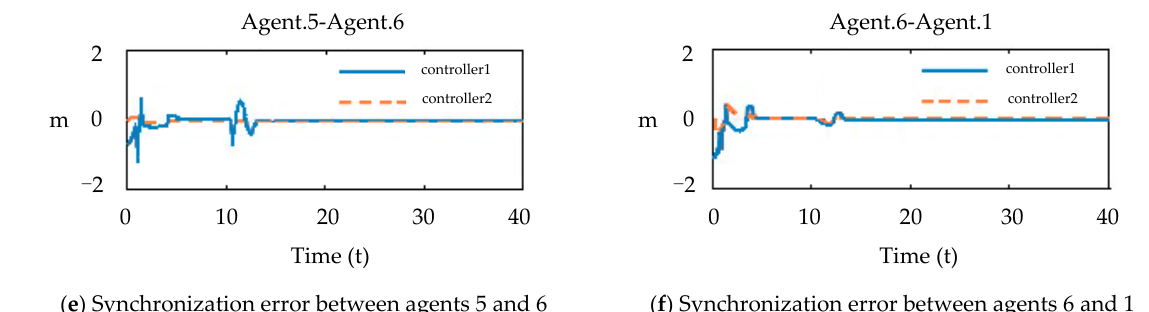
Figure 5. Synchronization error between two agents on X -axis.